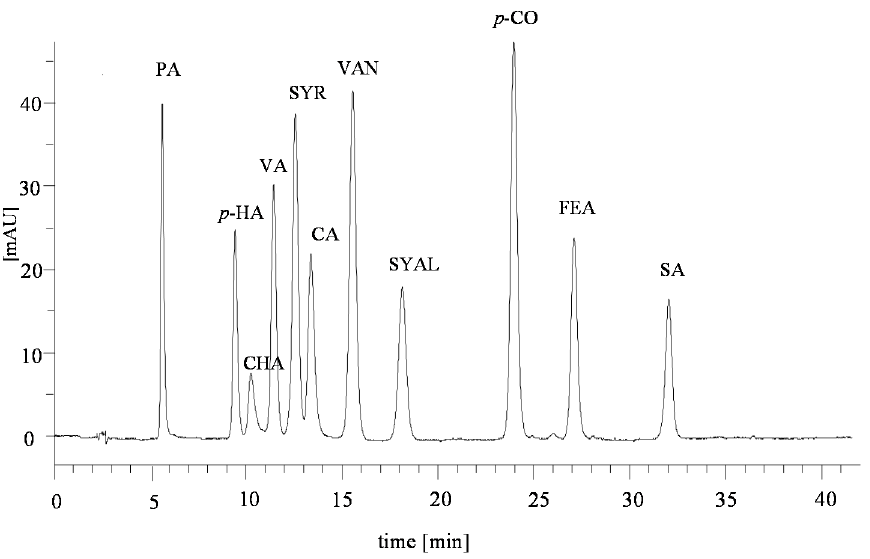
Figure 6. Phenolic compounds’ reference mixture chromatogram.